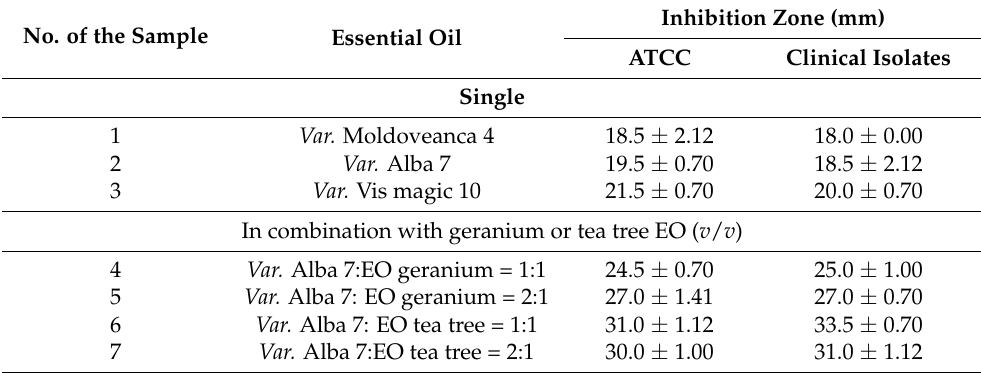
Table 4. Diameters of the inhibition zones of EOs against S. aureus . No. of the